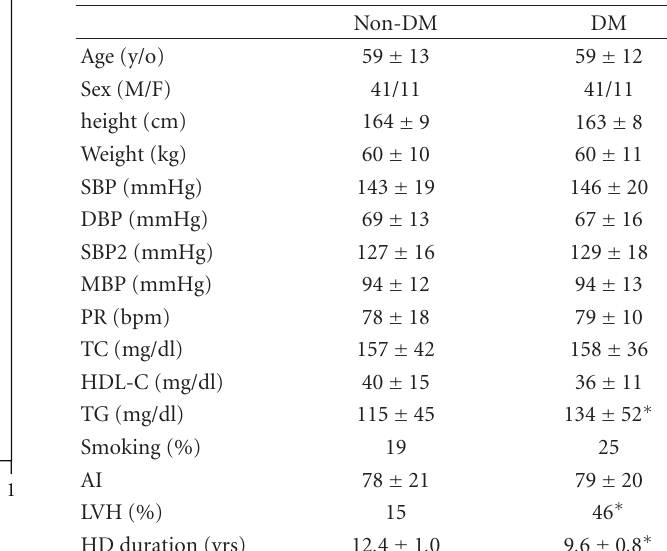
Figure 5: ROC curve for nondiabetic patients showed that AI of 87 was able to be used as a cuto ff value to (arrow) predict cardiovascular events.